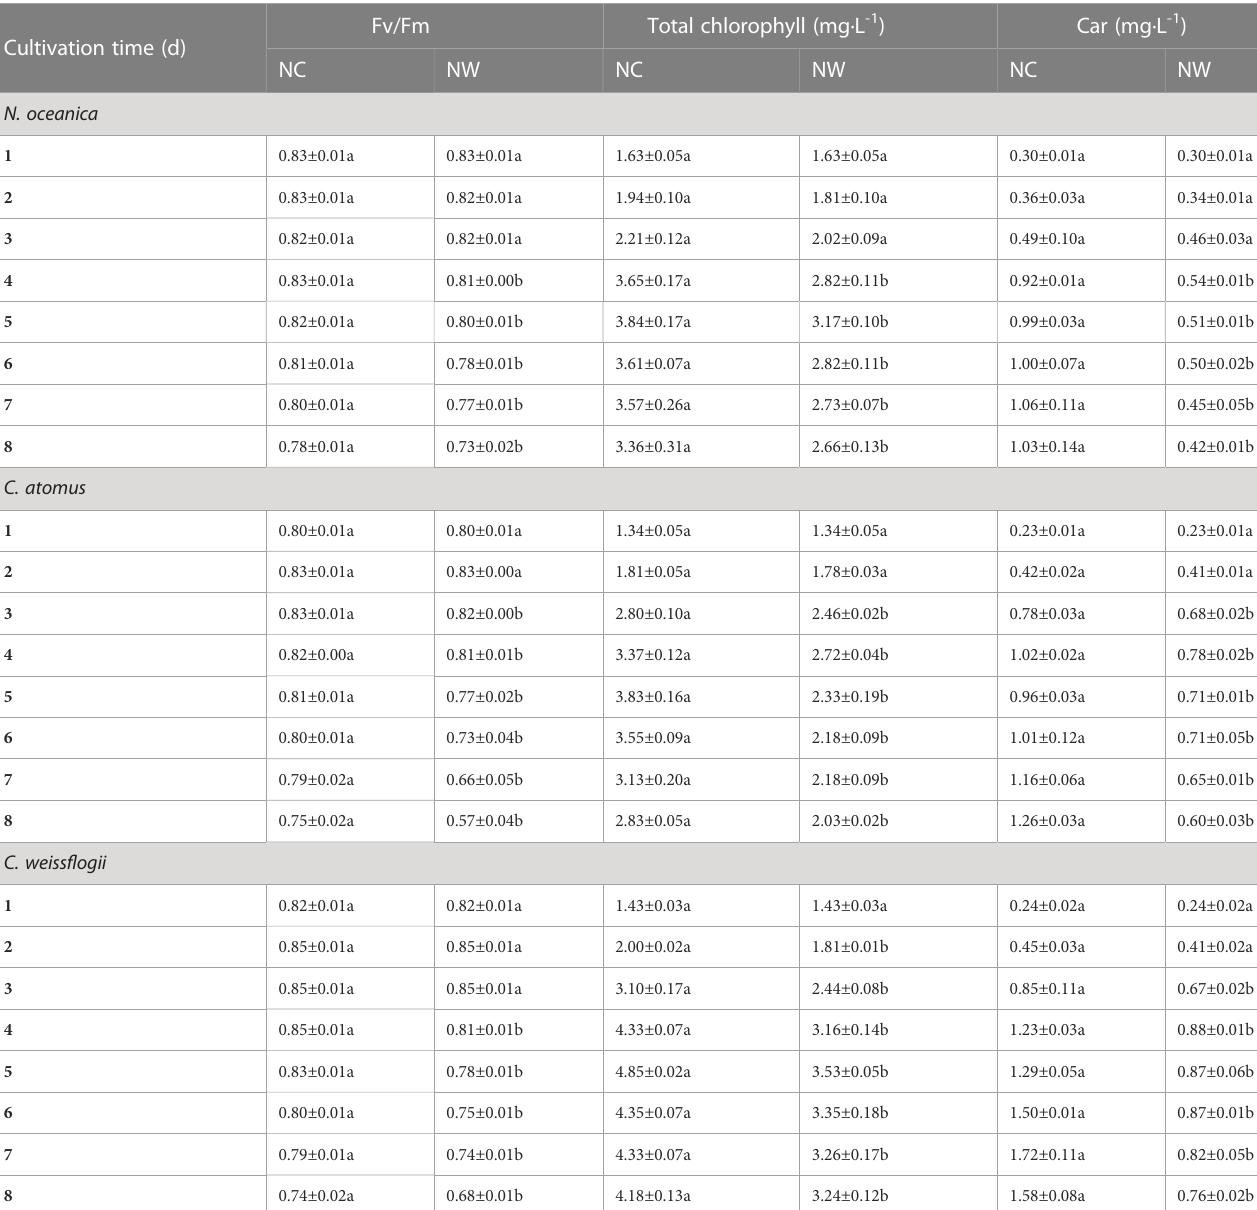
TABLE 1 The maximal quantum yield of PSII (Fv/Fm) and contents of total Chlorophyll and carotenoids (Car) in N. oceanica , C. atomus , and C. weiss fl ogii in two groups. Fv/Fm Total chlorophyll (mg·L -1 Cultivation time (d)